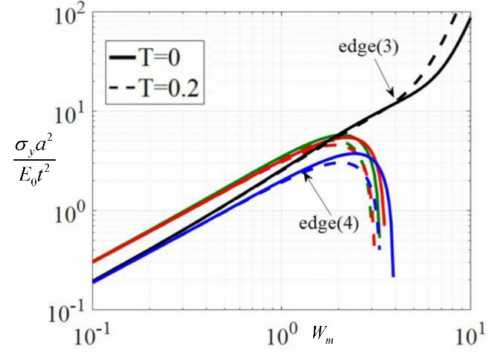
Figure 7. Variations of σ y a 2 / E 0 t 2 with W m at the